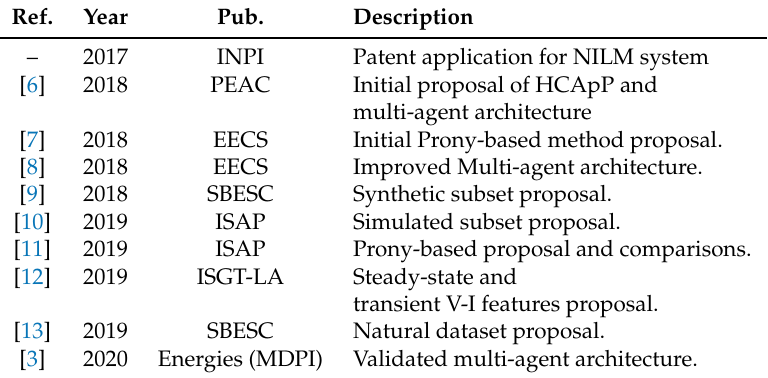
Table 1. Related publications from the same research